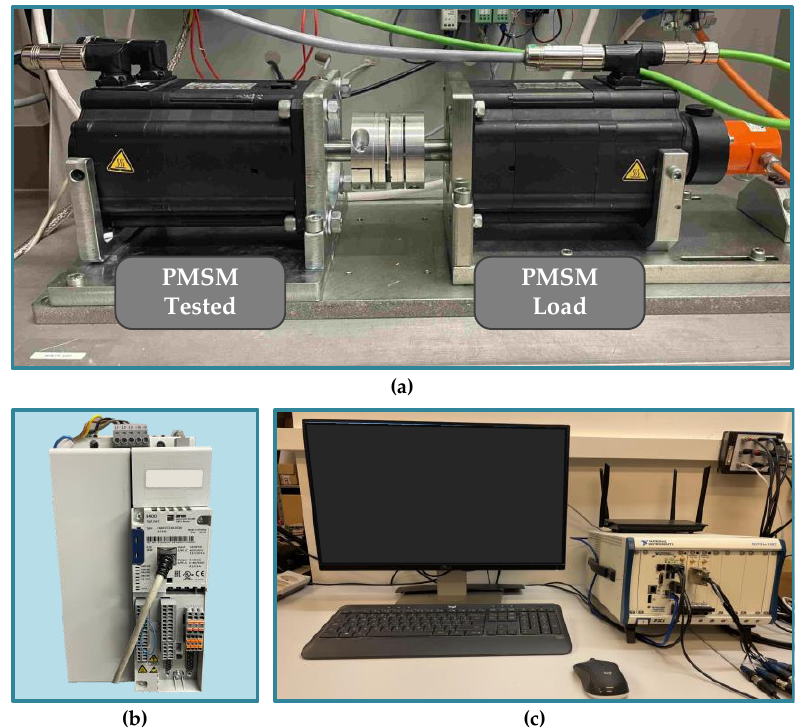
Figure 5. Real view of the experimental setup ( a ) motor test stand, ( b ) inverter Lenze 8400 Topline, ( c ) data acquisition system — industrial PC NI PXI 1082 (National Instruments, Austin, TX, USA) with NI DAQ card PXI-4492 (National Instruments, Austin, TX, USA).